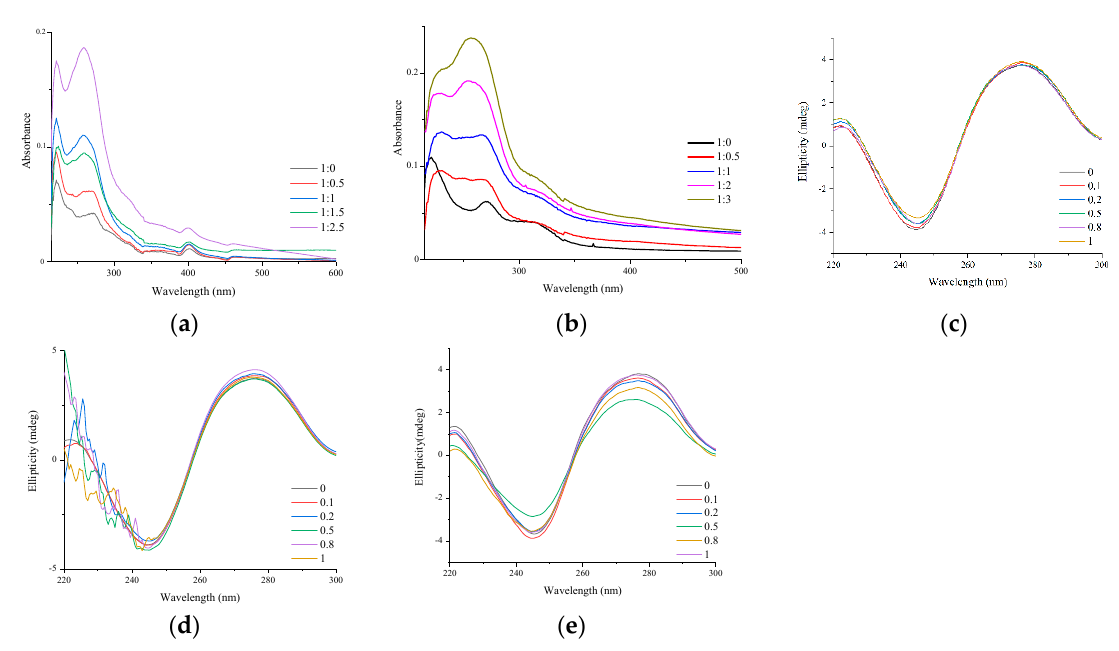
Figure 10. ( a , b ) UV-Vis spectra of 1 , 2 (5 × 10 − 6 M) in Tris buffer solution with increasing concentration of CT-DNA (0–1.5 × 10 − 5 M) at room temperature; ( c – e ): CT-DNA-circular dichroism (CD) spectra (CT-DNA 1.5 × 10 − 4 M) after 24 h incubation at different [DNA]/[complex] ratios at 37 °C.